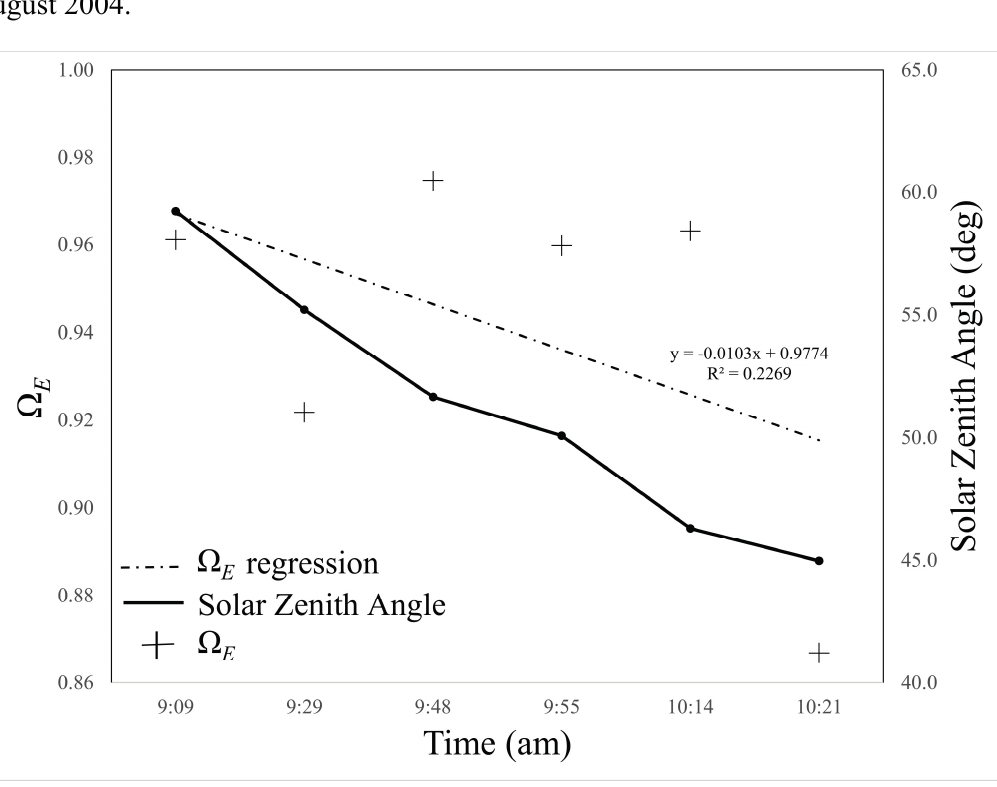
Figure 5. Changing solar zenith angle (degrees) on the element clumping index measured by TRAC. There was a slight positive association between the two variables: as solar zenith angle increased, clumping index increased (r 2 =